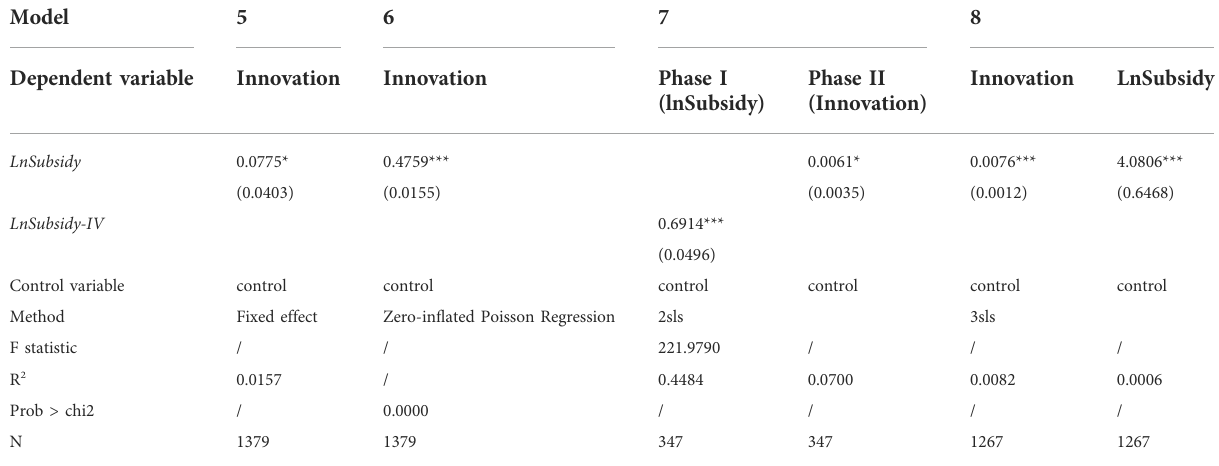
TABLE 5 Robustness test and treatment of reverse